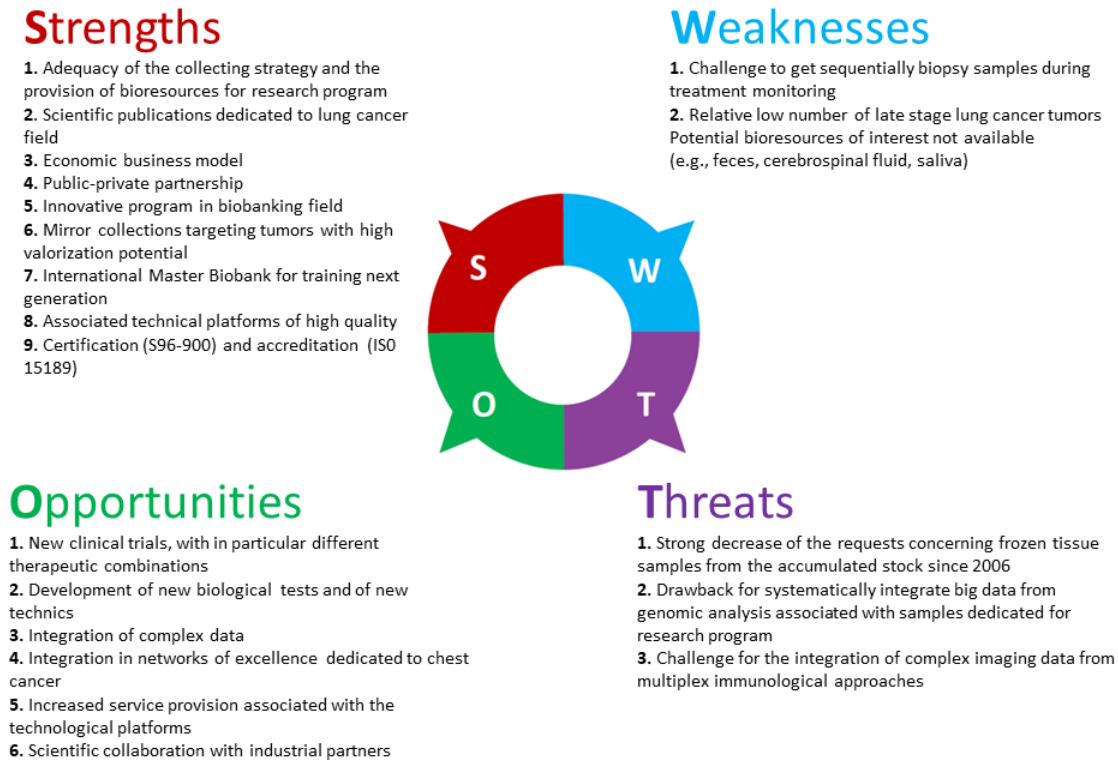
Figure 6. SWOT analysis of the biobank BB-0033-00025.